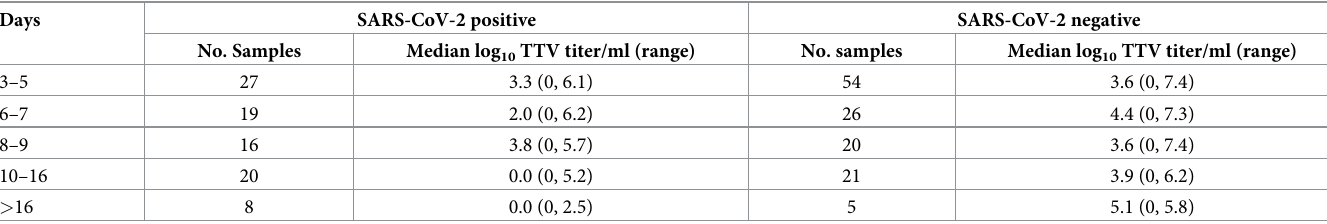
Table 3. Torquetenovirus titer in saliva as a function of days from symptom initiation in relation to SARS-CoV-2 status. Days SARS-CoV-2 positive SARS-CoV-2 negative No.